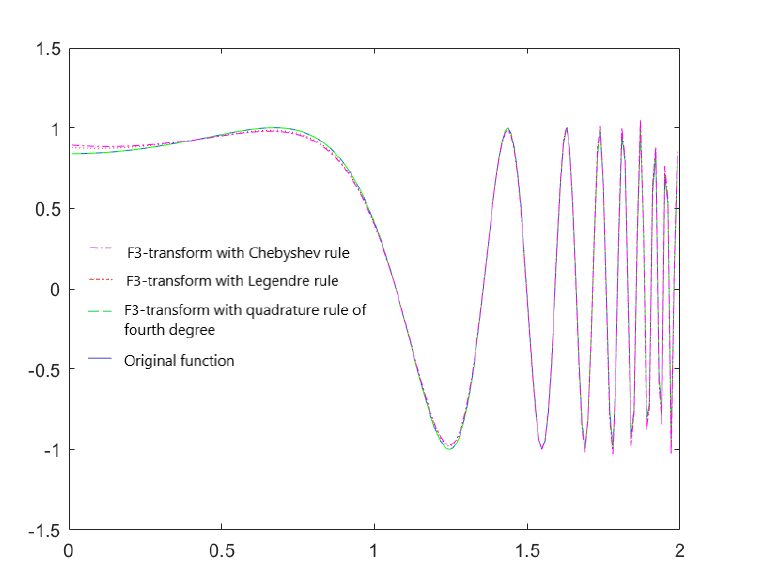
Figure 5. Original function f ( x ) = sin e x 2 and its three inverse F 3 -transforms whose components were calculated using the Legendre rule, Chebyshev and the here proposed 4-point Gaussian quadra- ture rule.